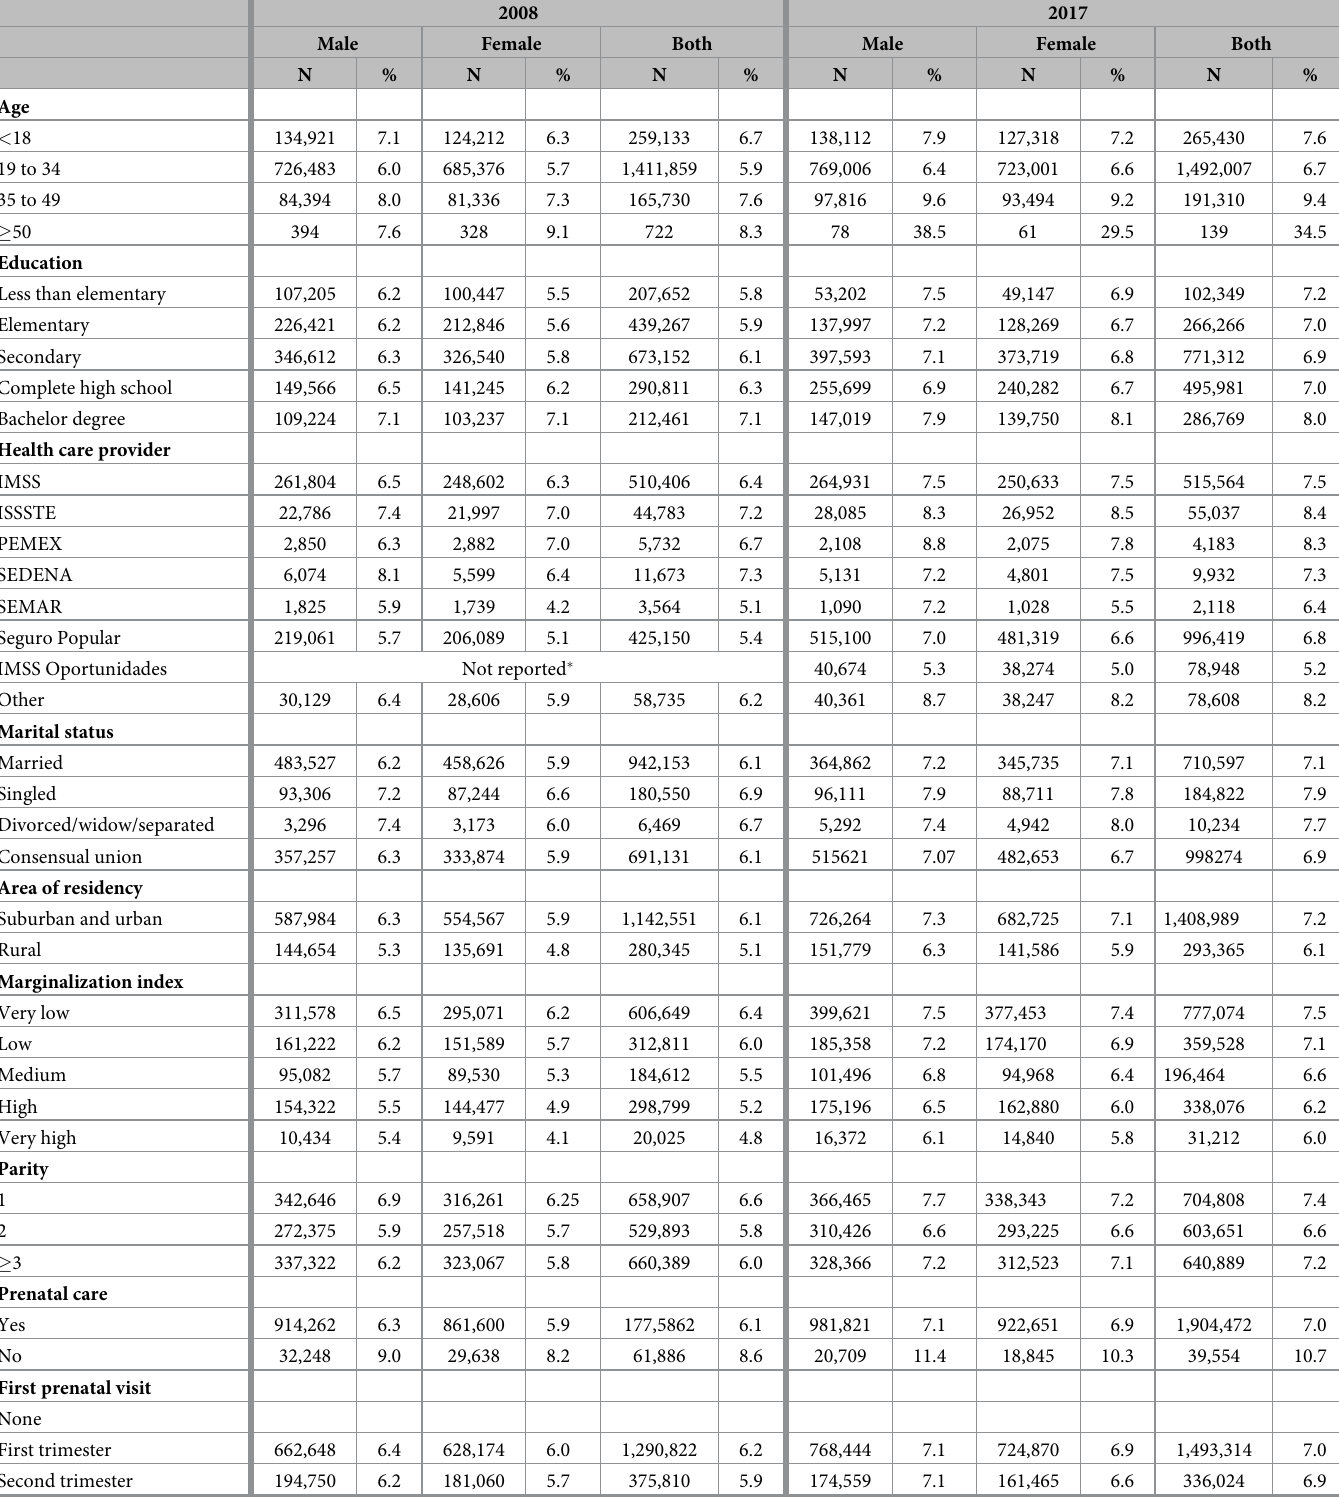
Table 2. Incidence of LBW according to maternal characteristics, 2008 and 2017.